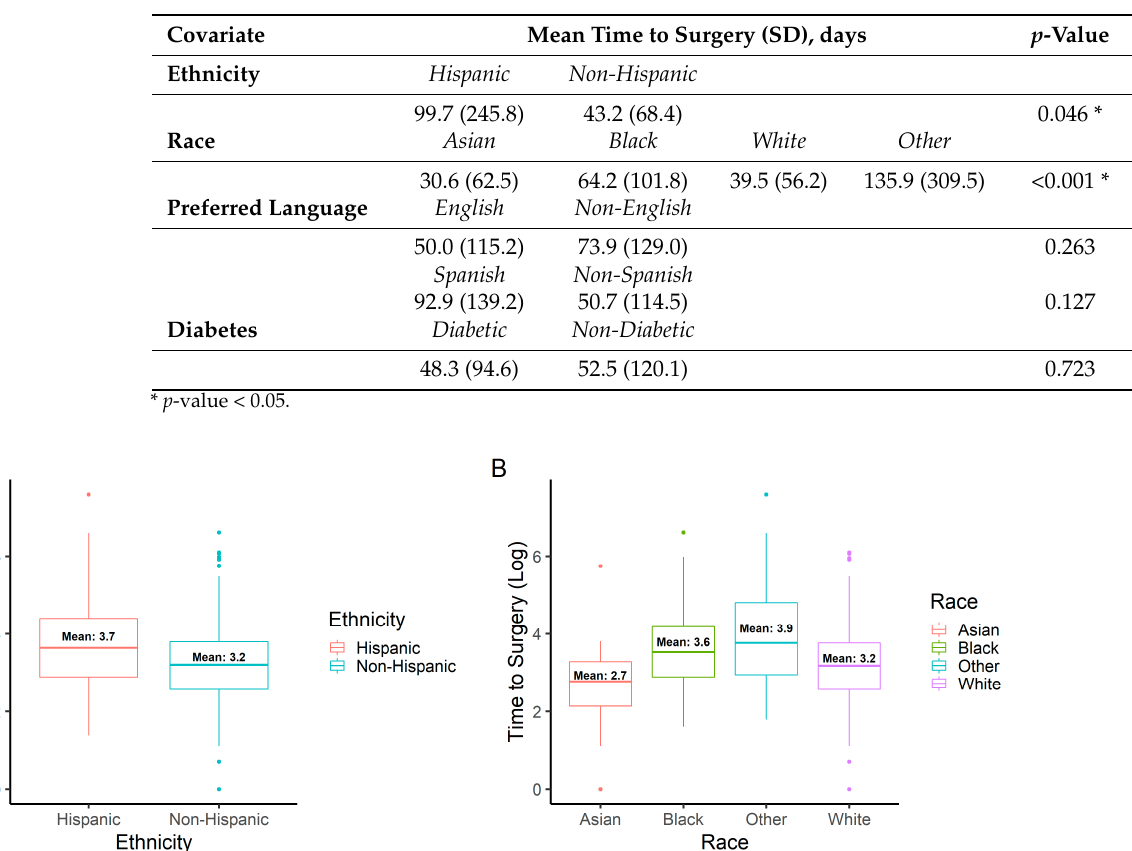
Table 2. Mean time to surgery (days) categorized by ethnicity, race, preferred language, and diabe- tes status.